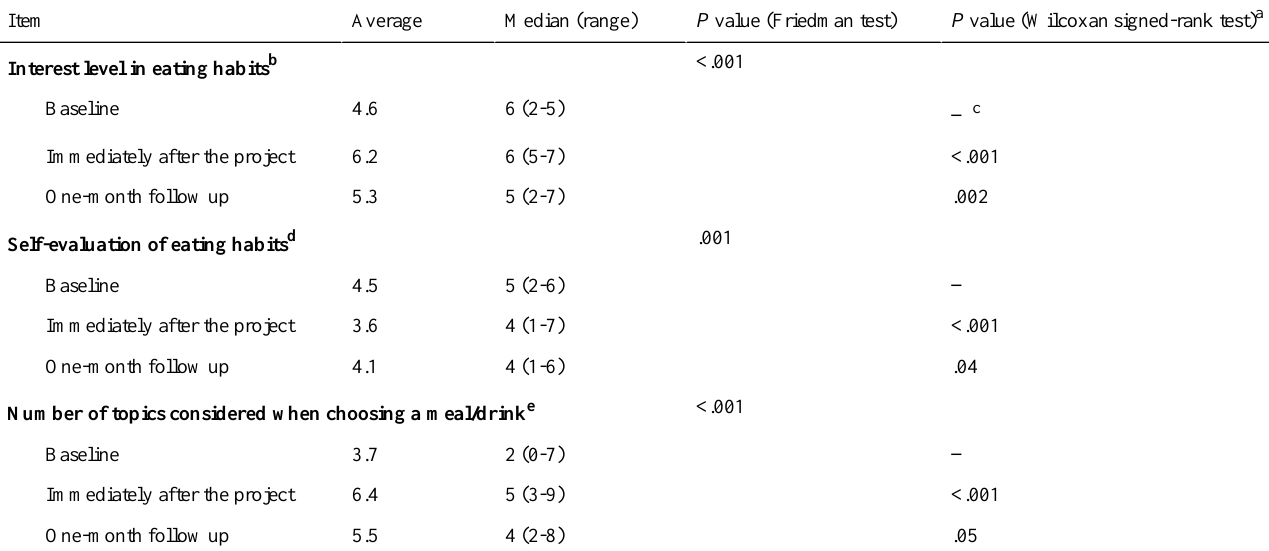
Table 2. Changes of participants’awareness associated with their eating habits through the intervention (N=38).